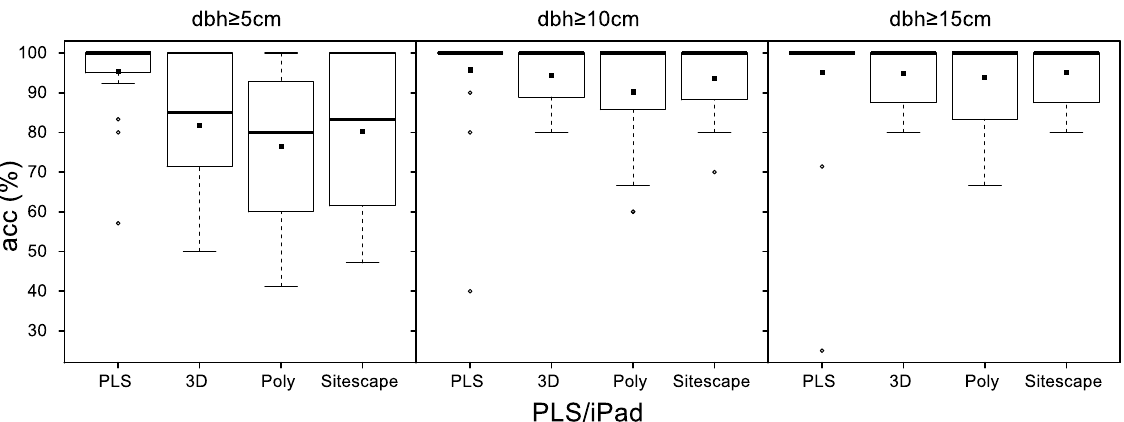
Figure 11. Distribution of overall accuracies for PLS/iPad and lower dbh thresholds. Black squares represent average de-